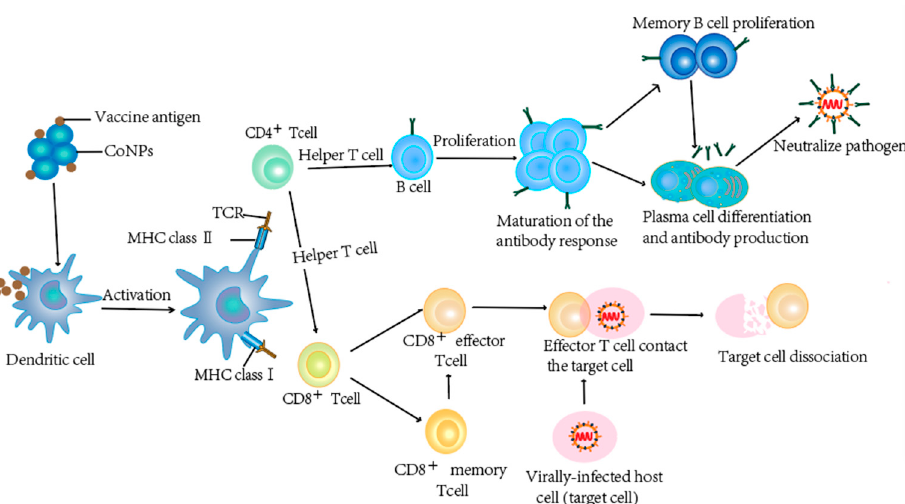
Figure 4. Cobalt nanomaterials can be used for vaccine delivery. Vaccines contain weakened or inactivated parts of specific organisms (antigen) that can trigger an immune response in the body, producing a small amount of antibodies and memory T cells and memory B cells. When the body is exposed to the same antigen again, these two cells quickly proliferate and differentiate to produce effector T cells and effector B cells (plasma cells) to quickly remove the antigen and then: plasma cells produce antibodies and neutralize antigen binding. Effector T cells and the target cells are in close contact, making the target cells lysis and death.